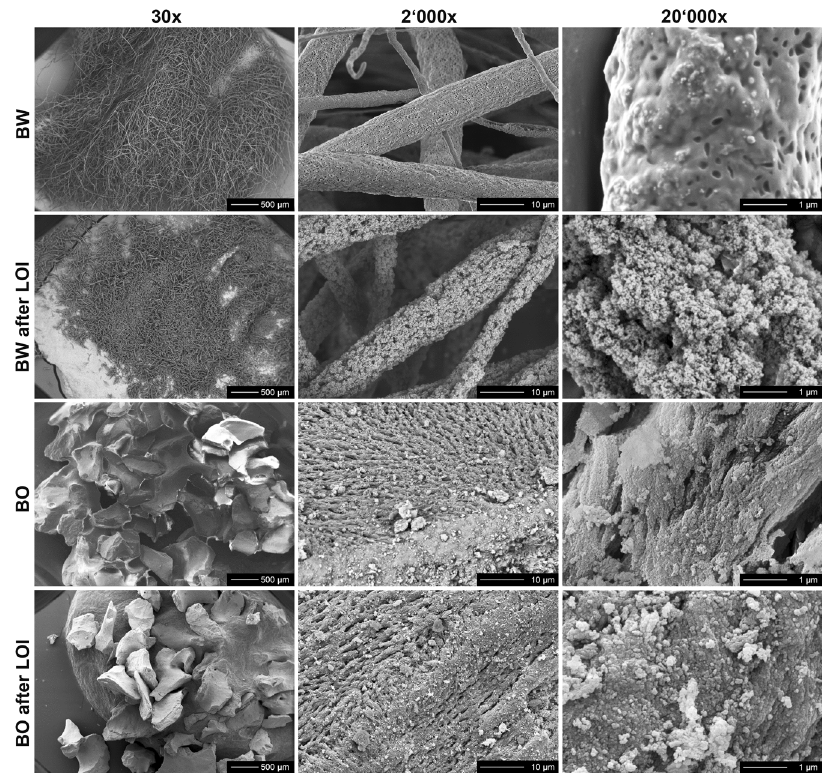
( p < 0.001). XRD-analysis of combusted samples revealed